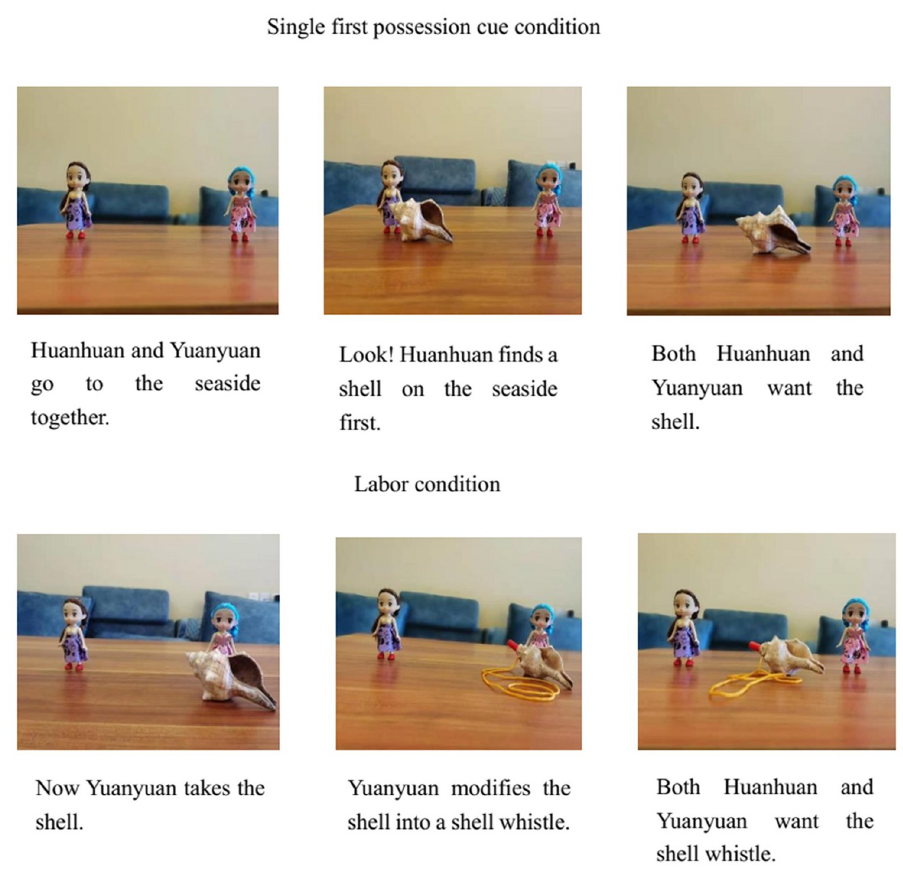
Fig 1. Procedures and scripts about the shell story in Study